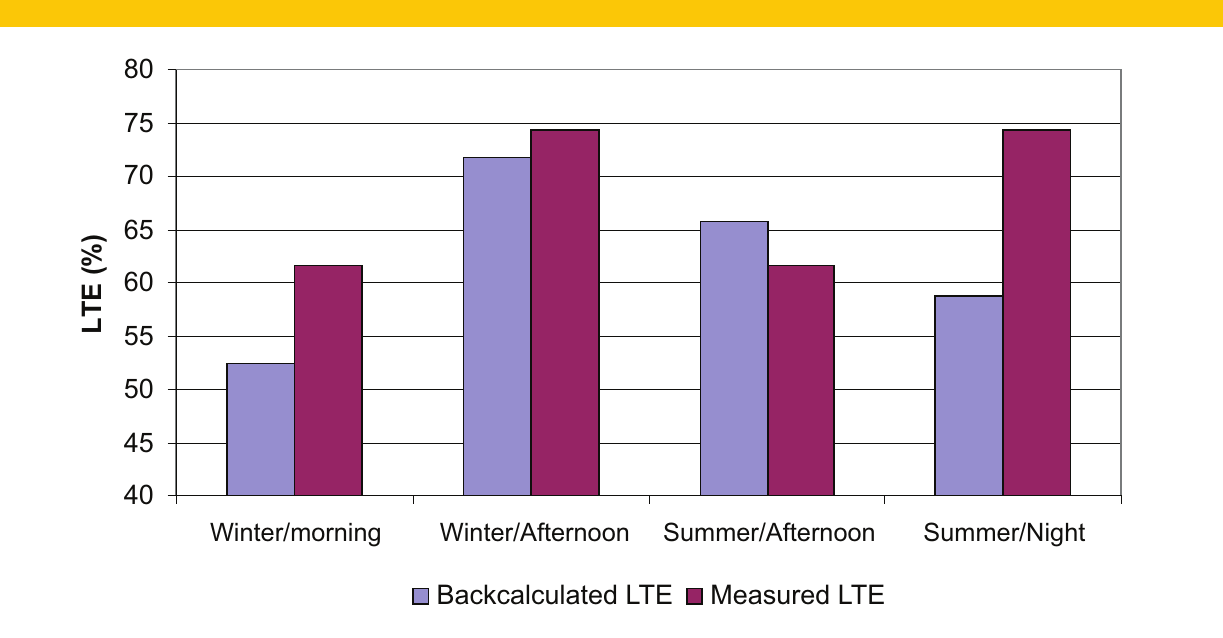
Figure 9 – Comparison of backcalculated and measured LTE values for joints without